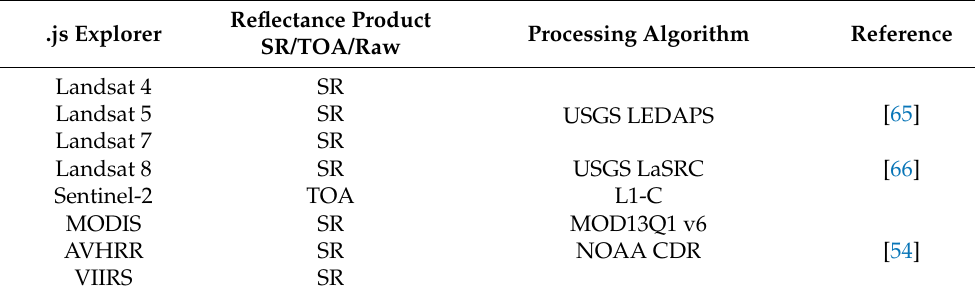
Table 3. Links to JavaScript (.js) scripts on the GEE for exporting pixel level NDVI extractions as time series, the surface reflectance or Top of Atmosphere (TOA) data products sampled, their processing algorithms for deriving surface reflectance, and supporting references. Reflectance Product Processing Algorithm .js Explorer SR/TOA/Raw